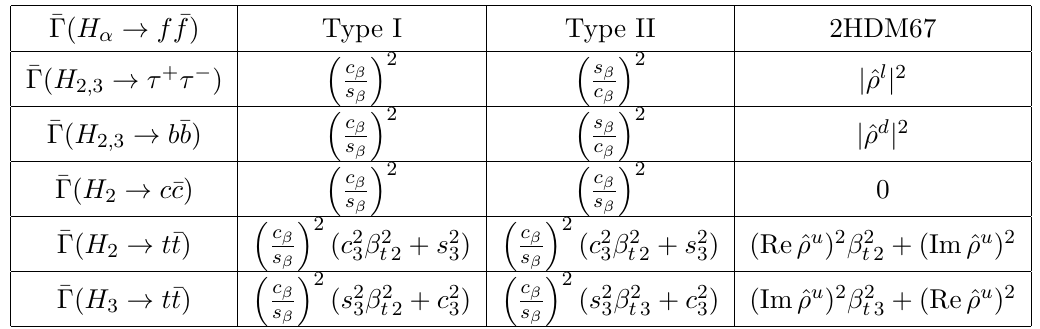
Table 2 . Rescaled decay widths (cid:22)(cid:0) for (cid:28) + (cid:28) (cid:0) , b (cid:22) b , c (cid:22) c , and t (cid:22) t (cid:12)nal states in the AL. For (cid:28) , b , and c , (cid:12) f (cid:11) was approximated by 1. For the 2HDM67 the assumption of eq. (4.38) was